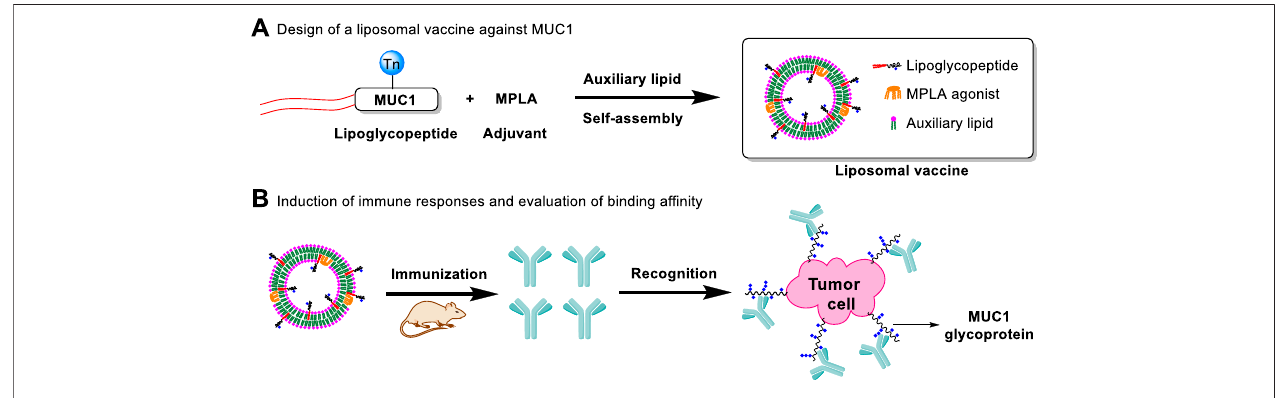
FIGURE 1 | Design of a liposomal vaccine consisting of auxiliary lipids, MUC1 lipoglycopeptides and MPLA adjuvant. (A) Design of a liposomal vaccine against MUC1; (B) Induction of immune responses and evaluation of binding af fi nity.